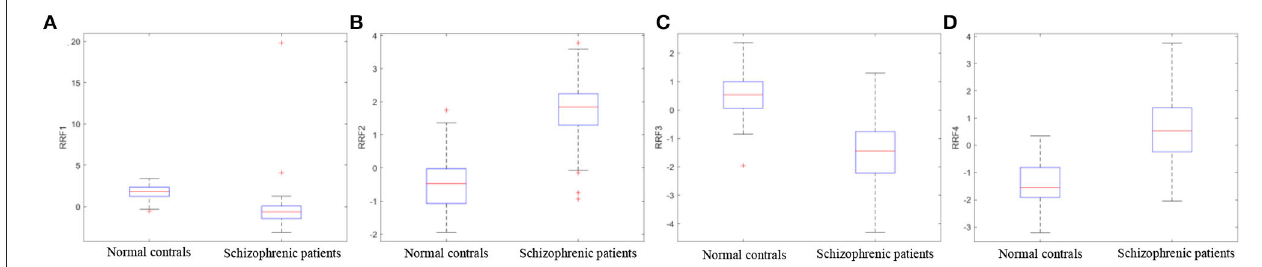
FIGURE 11 | The boxplots of RRF. (A–D) represent the boxplot of each feature in the RRF feature set.